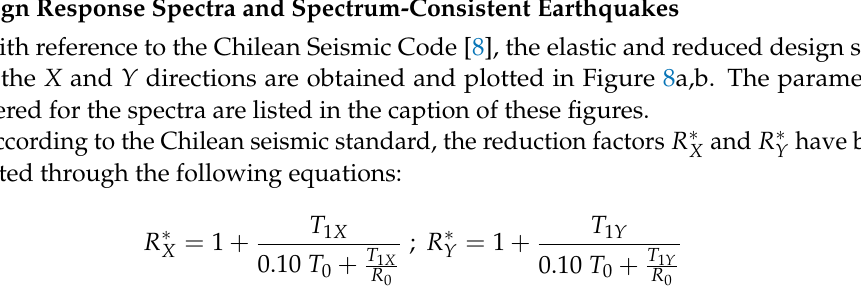
Figure 7. Shapes of the first four modes of the building (a high deformation scale factor is